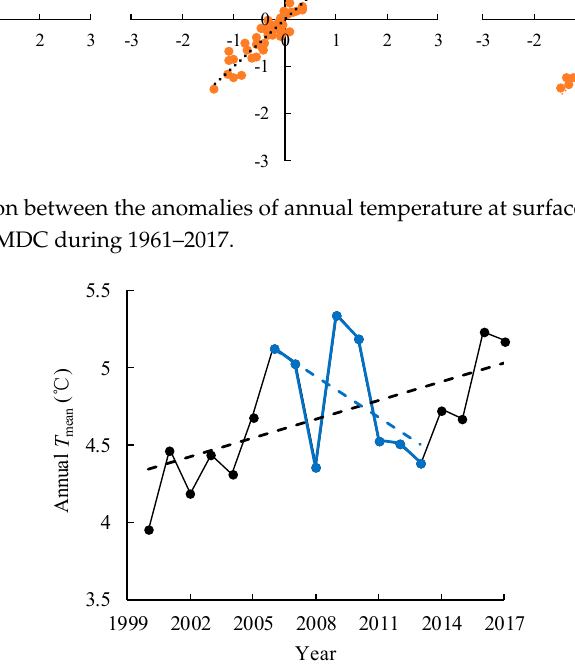
Figure S3. Short-term reduction trend over the mid-south of Tibetan Plateau from the mid-2000s to 2013. Table S1. Detailed information of the selected meteorological stations.